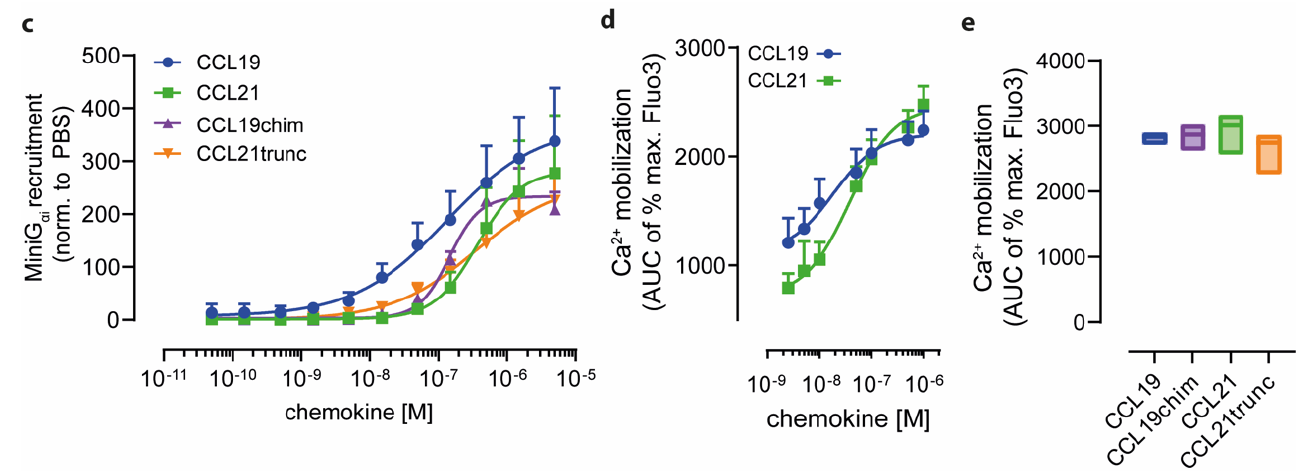
Figure 1. Ligand-biased CCR7 signaling only partially relies on the C terminal tail of CCL21. ( a ) Schematic representation of native CCL19 and CCL21, the naturally occurring C-terminally truncated chemokine variant CCL21trunc and CCL19chim, a CCL19 variant extended by the CCL21 ′ s C terminus (marked in red). Characteristic disulfide bonds (dashed lines) between cysteine (C) residues and the specific chemokine length indicated by the number of the last amino acid are depicted. ( b ) β arrestin2-NLuc158 recruitment to CCR7-NLuc11 upon chemokine stimulation with graded concentrations of each chemokine variant. The area under the curve (AUC) analysis for each chemokine representing the mean ± SD of n = 3 is shown. ( c ) LgBit-MiniG α i is recruited to CCR7-NLuc11 in a concentration-dependent manner for all tested chemokine variants. Normalized mean AUC values ± SD of n = 3 are shown. ( d ) Calcium mobilization in 300-19 pre-B cells expressing CCR7 in response to graded concentrations of native CCL19 and CCL21. Mean AUC values ± SD of three independent experiments that were normalized to the maximal fluorescence achieved with ionomycin are shown. ( e ) Experimental setup as in ( d ). 300-19 cells expressing CCR7 were stimulated with 50 nM of the indicated chemokine. Median AUC values from min. to max. of n = 3 are shown.